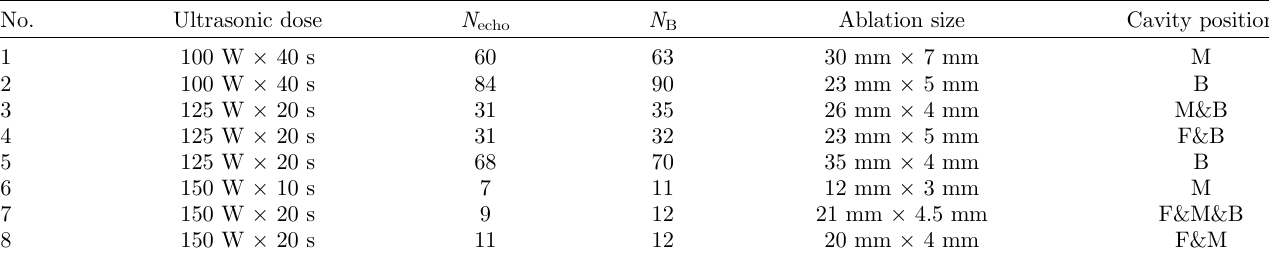
Table 3. Medium and high dose ablation